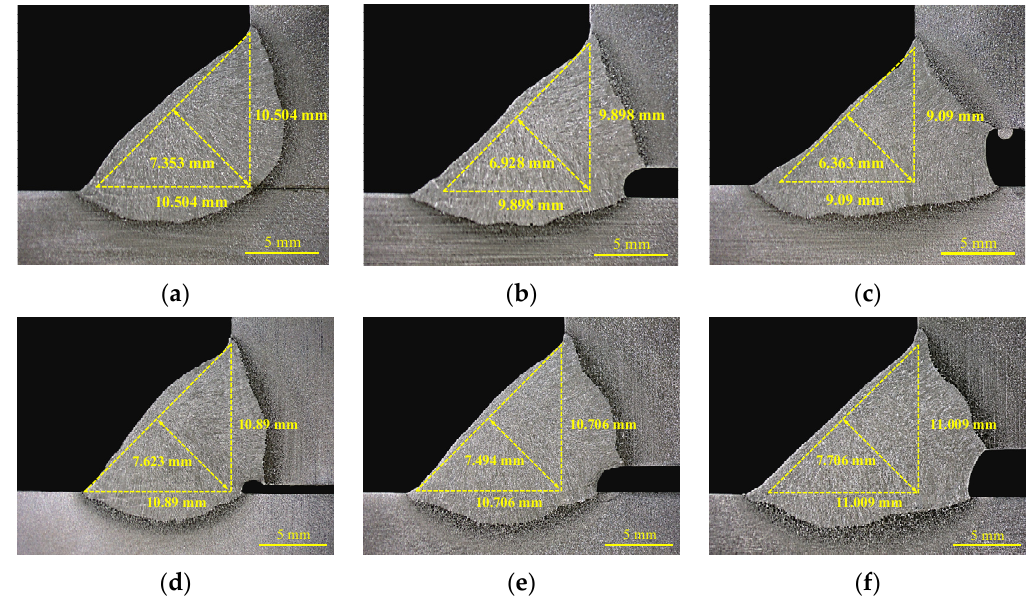
Figure 16. Weld bead cross-sectional comparison with and without quality control (optimal conditions for 0 mm gap): ( a – c ) without real-time weld quality control, and ( d – f ) with weld quality control based on the proposed DNN method.